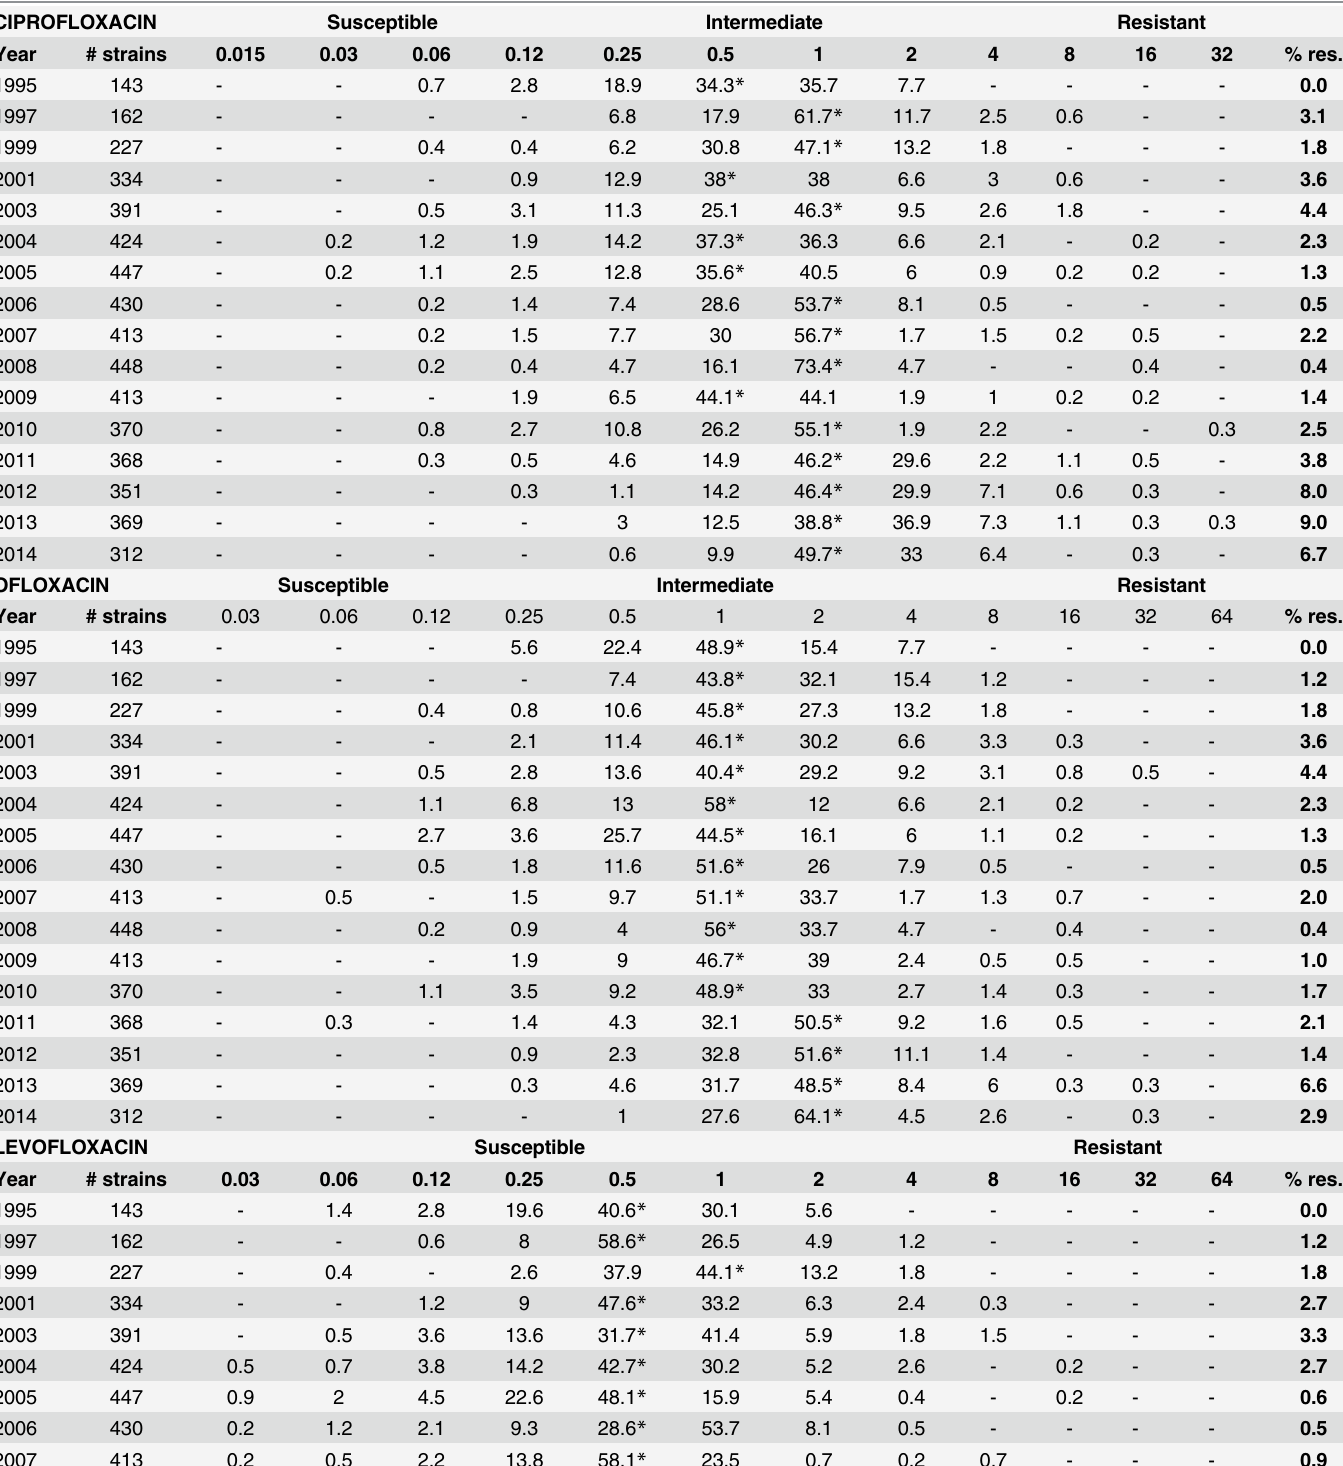
Table 1. Yearly percentage of isolates displaying indicated MIC ( μ g/mL) against four fluoroquinolones. The MIC 50 values are indicated with an aster- isk. The breakpoints (separating the isolates according to their susceptibility to each drug) are those set by EUCAST.